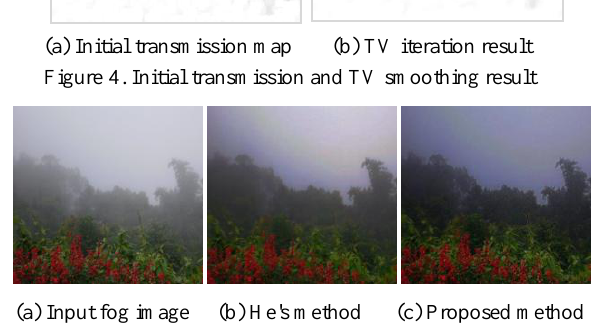
Figure 5. Comparison with He's work